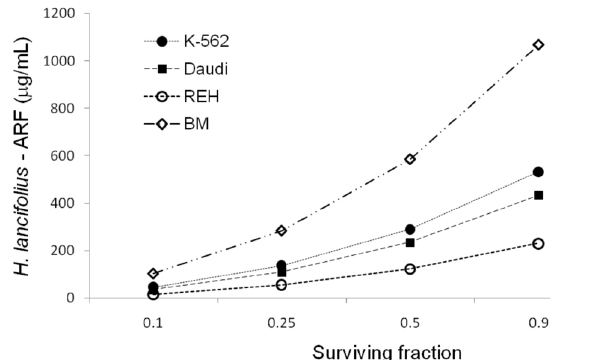
FIGURE 2 – Effect of alkaloid-rich fraction of H. lancifolius on cell survival. The indicated cell lines were plated out in the presence of the H. lancifolius ARF. Each point represents the surviving fraction of leukemic cell lines recovered after exposure for 48 h at 37 °C. The 0.5 point represents the IC each cell